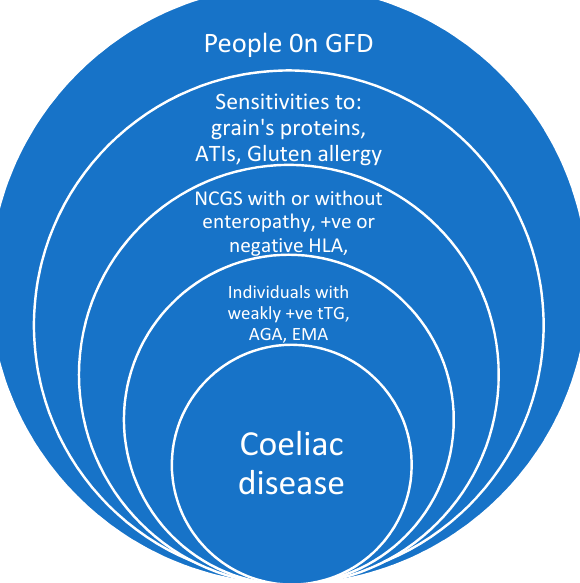
Figure 1. Gluten-related disorder, tTG: Tissue transglutaminase antibodies, AGA: Antigliadin antibodies, EMA: Endomysial antibodies, NCGS: Non-coeliac gluten sensitivity, ATIs: Amylase/trypsin inhibitors.